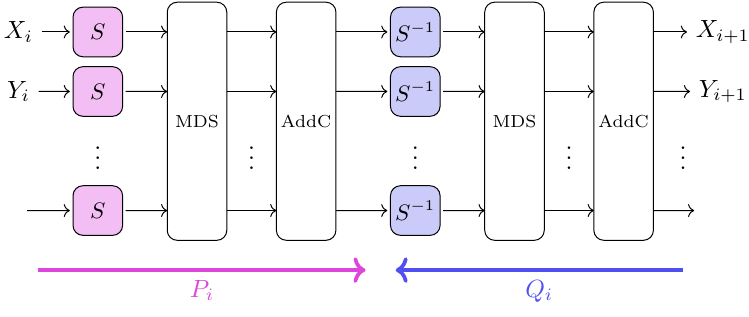
Figure 6: Round 𝑖 of